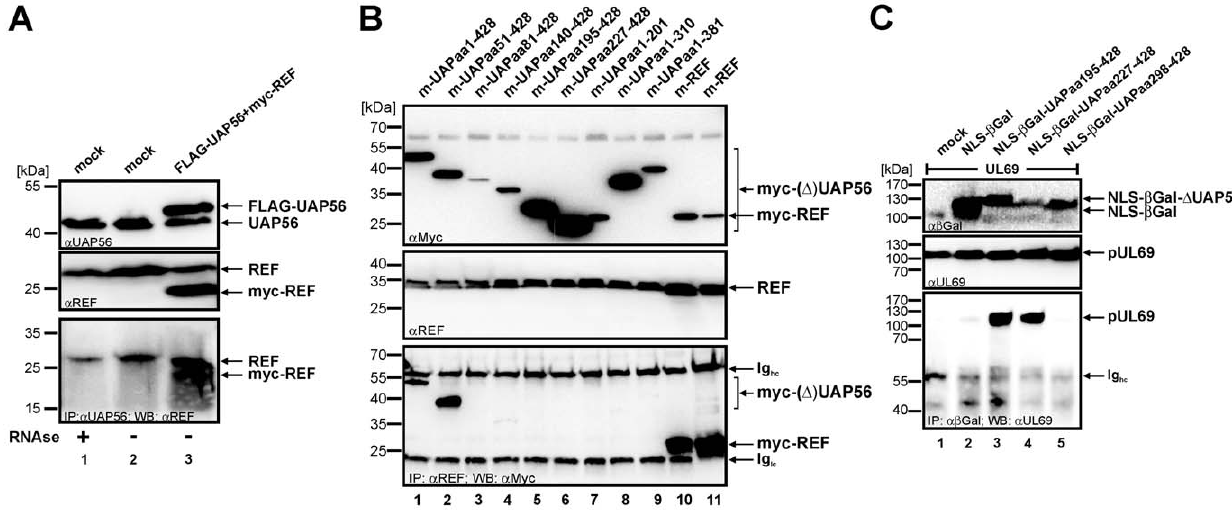
Figure 6. Confirmation of UAP56 interaction domains in mammalian cells. Coimmunoprecipitation analyses to confirm the interaction of endogenous UAP56 and REF (A) and to map the UAP56-domains required for (B) REF- or (C) pUL69-interaction. (A) HEK293T cells were either mock transfected (lanes 1 and 2) or cotransfected with plasmids encoding FLAG-tagged UAP56 and myc-tagged REF (lane 3). The expression of endogenous proteins and proteins after transfection was controlled by Western blot analysis using an a -UAP56 antibody (anti-BAT1) (A, upper panel) and an a -REF antibody (A, middle panel). Immunoprecipitation was performed using an a -UAP56 antibody followed by detection of coprecipitated proteins with a -REF antibody (A, lower panel). The position of detected proteins is indicated on the right of each panel (UAP56, FLAG-UAP56, REF, myc-REF). Lysates of lane 1 were treated with RNase in order to exclude a bridging of proteins by RNA. (B) HEK293T cells were transfected with plasmids encoding either myc-tagged-UAP56 variants (lanes 1–9, as indicated) or myc-tagged REF (lanes 10 and 11). The correct expression of proteins after transfection was controlled by Western blot analysis using an a -myc antibody (B, upper panel). Expression of REF (either endogenous or transfected) was also verified by Western blot analysis using an a -REF antibody (B, middle panel). Immunoprecipitation was performed using an a -REF antibody followed by detection of cotransfected proteins with a -myc antibody (B, lower panel). The position of detected proteins is indicated on the right of each panel (Ig hc = immunoglobulin heavy chain; Ig lc = immunoglobulin light chain). (C) HEK293T cells were co-transfected with a plasmid encoding pUL69 in combination with vectors coding either for b -galactosidase alone or for fusions of UAP56 with b -galactosidase (as indicated). Expression of b -galactosidase fusion proteins and pUL69 was confirmed by Western blot experiments (C, upper and middle panel,